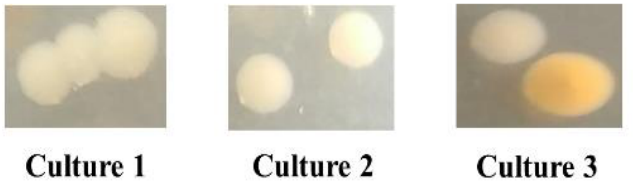
Figure 3. A depiction of recovered bacterial colonies from worms grown with both isolates. Majority of colonies (white colonies) belonged to Comamonas sp. 12022 MYb131, at a dilution factor of the worm homogenate at 10 − 4 dilution, which further supports the isotope-labeling findings. Orange colony represents Chryseobacterium sp. CHNTR56 MYb120. The images of the colonies were zoomed in on to show the bacterial color properly at the indicated dilution where bacterial colonies can be deciphered.